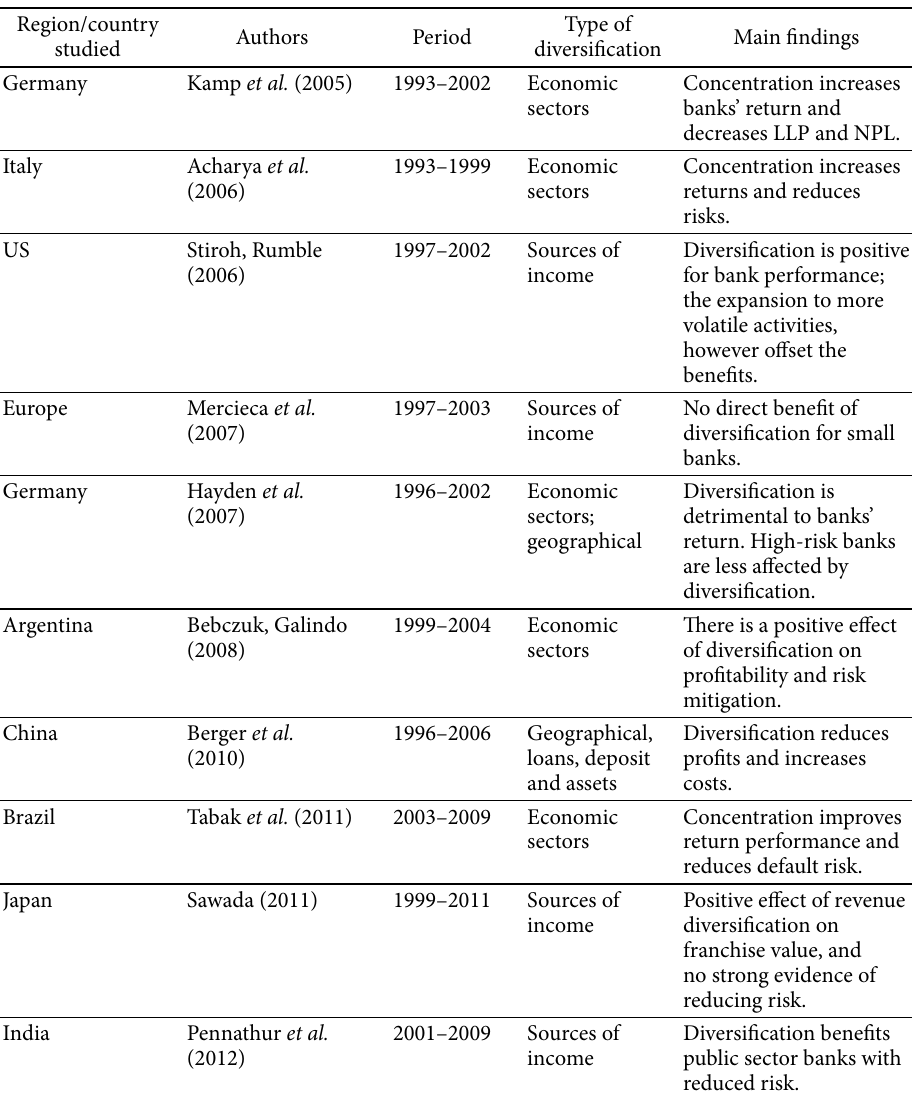
Table 1. Summary of recent researches on the impact of diversification on banks’ return and risk Region/country